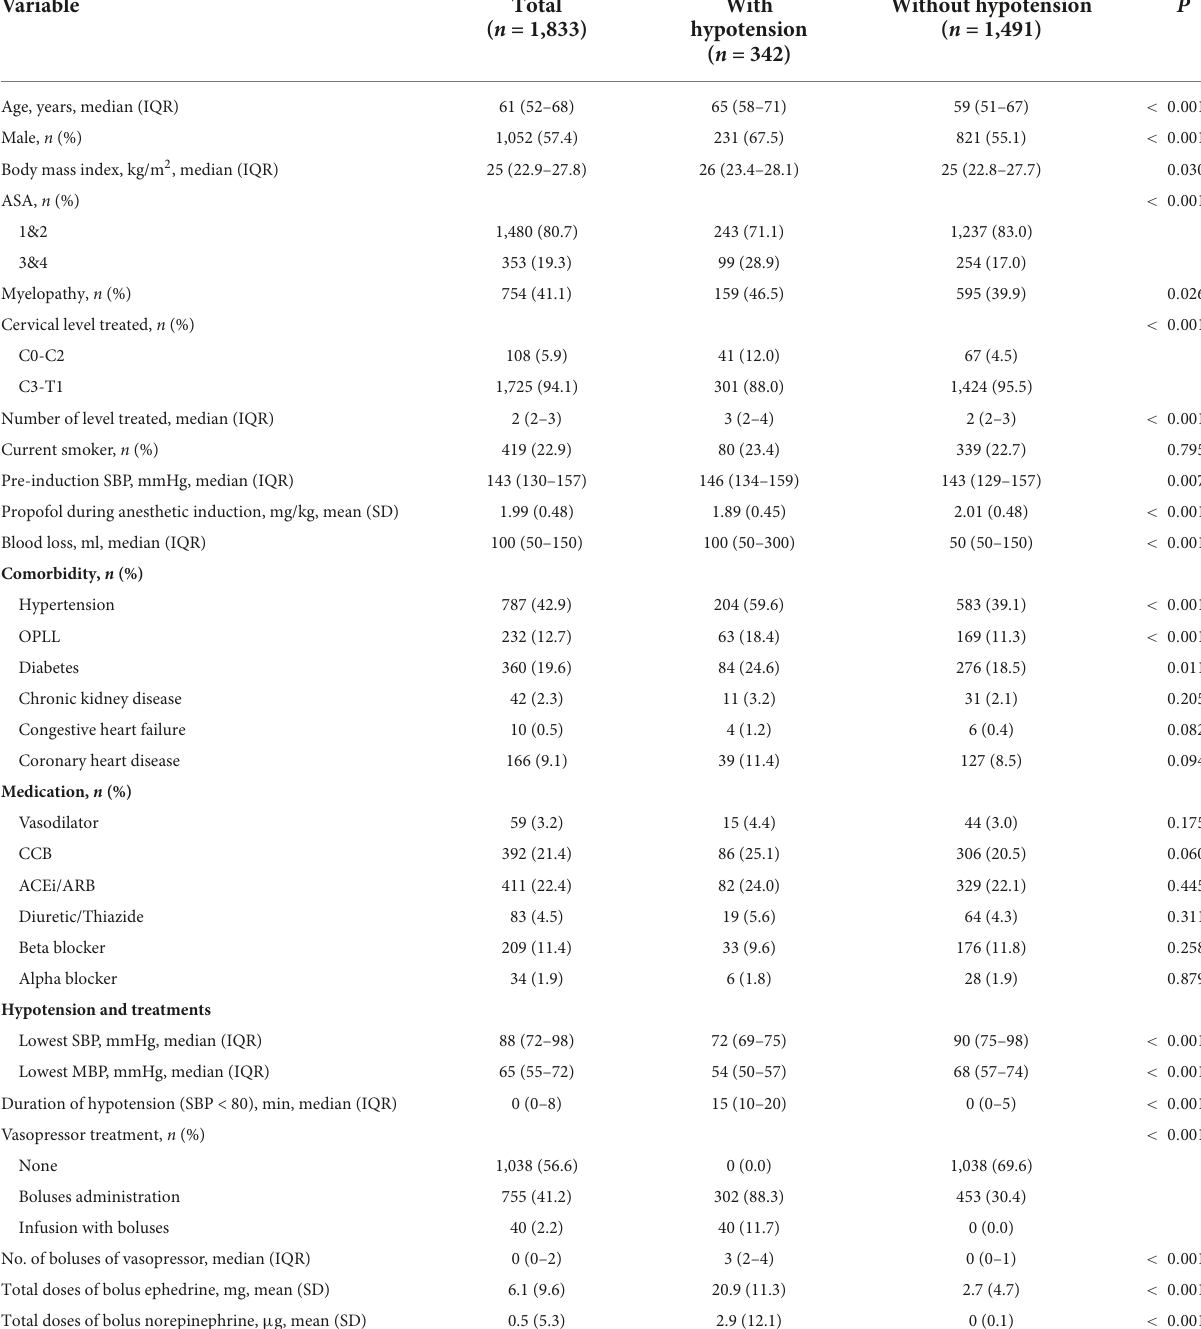
TABLE 1 Demographic and clinical characteristics stratified by the presence of intraoperative hypotension.